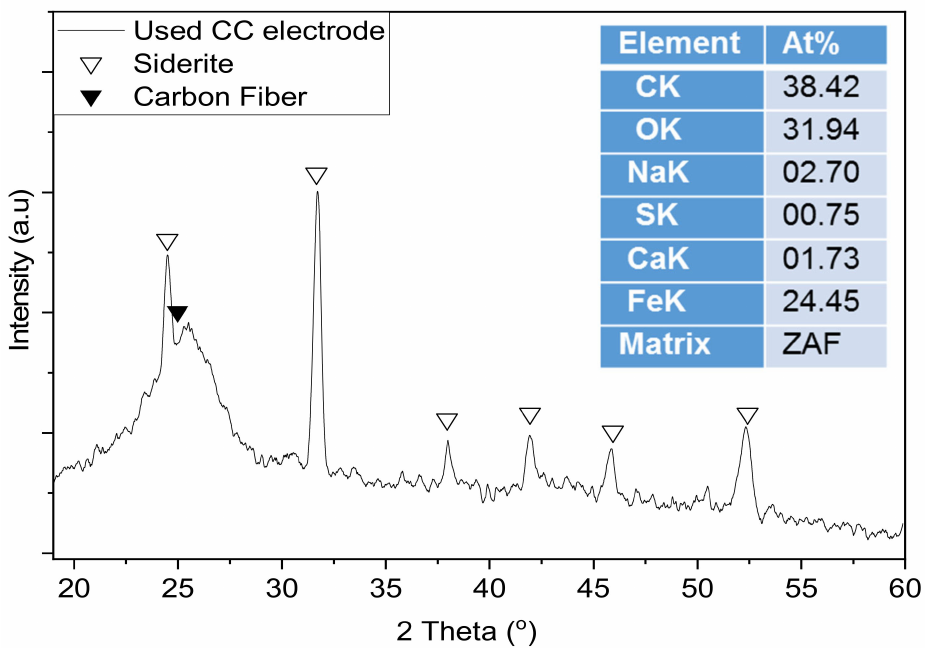
Figure 7. XRD pattern of a used electrode. Siderite and carbon fiber peaks are marked with a white and black triangle, respectively. The inset table shows the elemental atomic composition of a wide area of the used CC